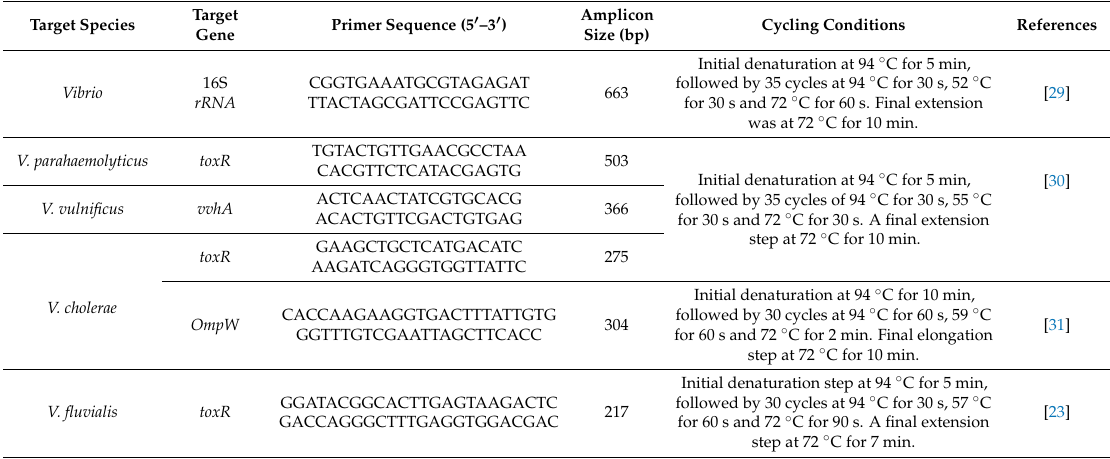
Table 1. Primer sequences and expected amplicon size of PCR amplified gene targets for Vibrio species. Target Species